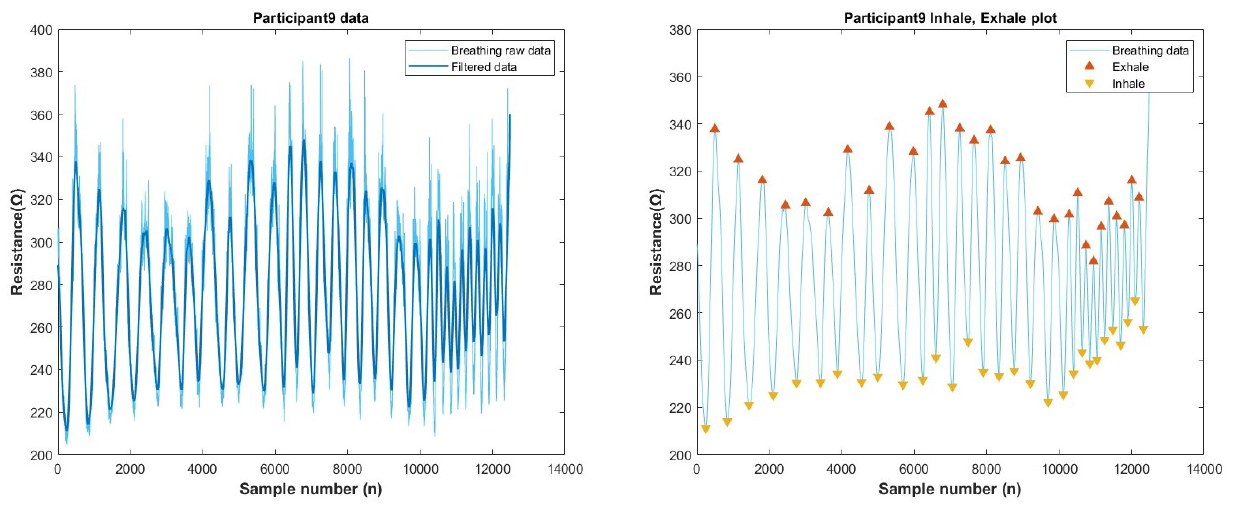
Figure A24. Breathing Test data of Participant number-9.